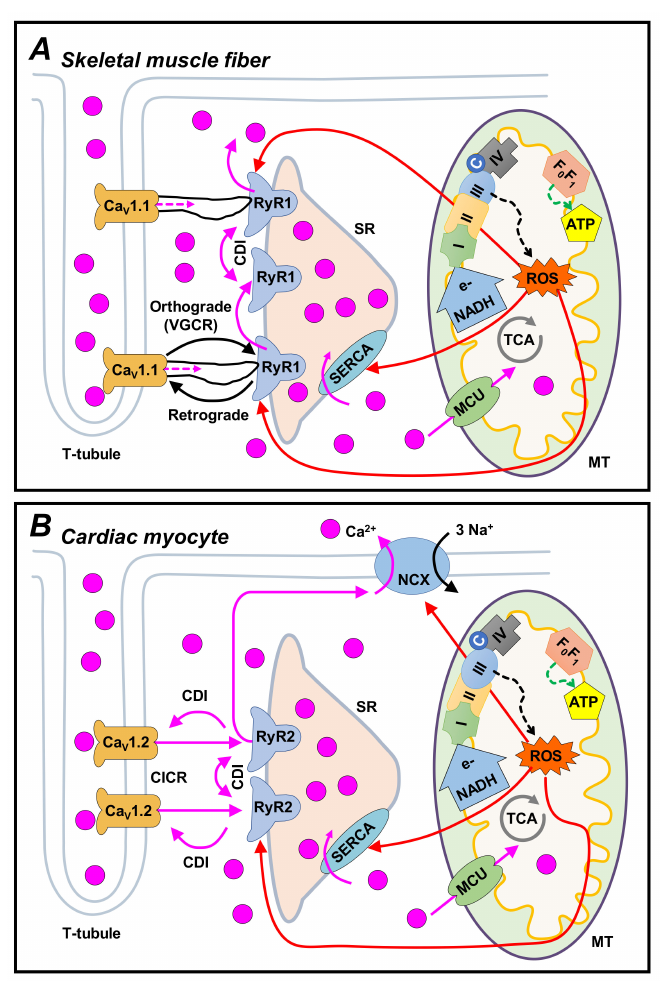
Figure 1. The voltage-gated Ca 2 + channels (VGCCs) govern feedback mechanisms of the T-tubule-SR junction and, thereby, also influence the SR-mitochondria communication. The figure illustrates the principal bidirectional signaling pathways that operate in skeletal ( A ) and cardiac ( B ) muscle. In both cases, an action potential (AP) activates Ca 2 + channels of the sarcolemma ( Ca V 1.1 and Ca V 1.2 ), which promotes SR Ca 2 + release via RyRs ( RyR1 and RyR2 ), in a process known as EC coupling ( orthograde signaling). The underlying mechanisms, however, are distinct. In the latter, the Ca V 1.2 to RyR2 communication consists in Ca 2 + -induced Ca 2 + release ( CICR ), whereas in the former, the Ca V 1.1 channels directly activate RyR1s, thanks to a physical link (Ca 2 + is not required, and, thereby, this phenomenon is also known as voltage-gated SR Ca 2 + release, VGCR ). The rise in [Ca 2 + ] i activates the SERCA pump and the NCX, returning [Ca 2 + ] i to baseline levels—with the aid of Ca 2 + -dependent inactivation of both RyRs and Ca V 1.2 ( CDI ). A small portion of Ca 2 + ions permeates into the mitochondrion (MT), e.g., via the mitochondrial Ca 2 + uniporter (MCU). Then, a symbiotic relationship between the SR and mitochondria occurs, because the calcium ions stimulate the synthesis of ATP, which is required for not only SERCA activity but also the cross-bridge cycle of contraction. In parallel, the tricarboxylic acid (TCA) cycle generates reducing equivalents (e.g., NADH) which are transferred to the electron transport chain (complexes I–IV), whose activity produces superoxide ion (O − , dashed black line) which, in turn, is converted into H 2 O 2 . The latter is a substrate for the Fenton reaction (forming hydroxyl radical, OH - ). These reactive oxygen species (ROS) can react with (and modulate) the EC-coupling related proteins (red lines), creating a delicate balance that contributes to optimal muscle performance. Nevertheless, an excessive rate of ROS generation can lead to severe oxidative damage, EC uncoupling, and cell